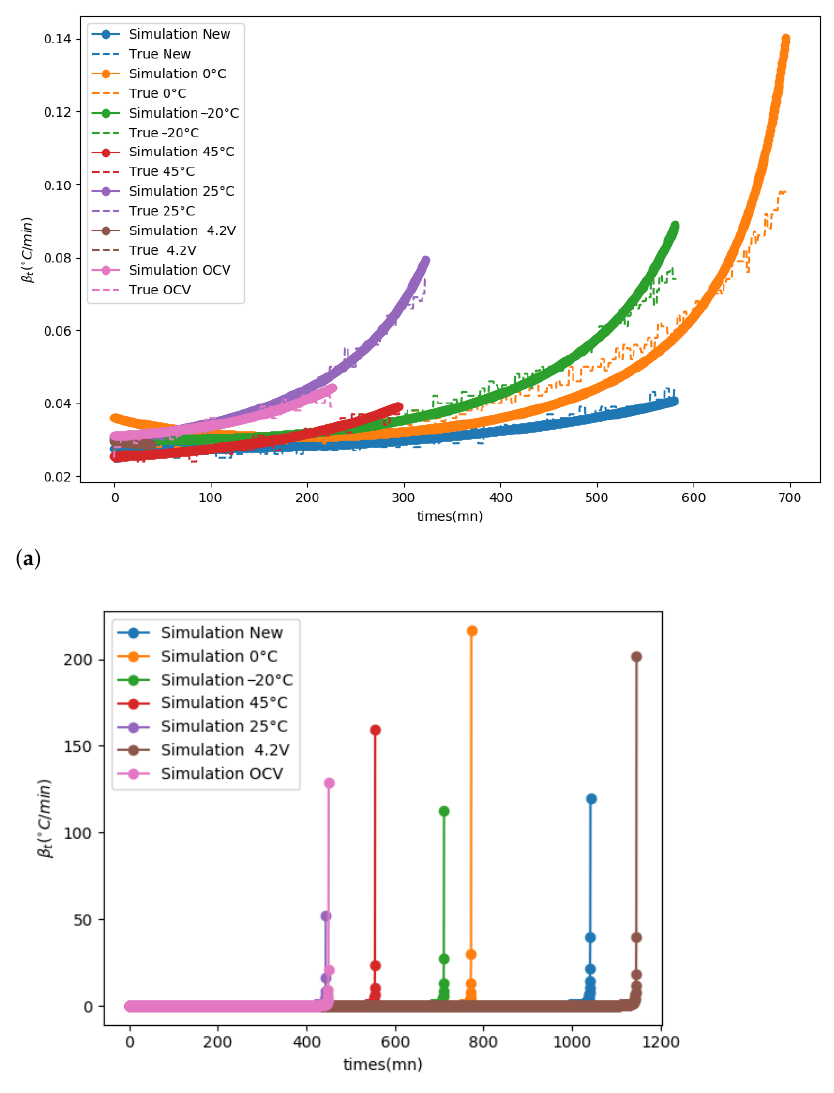
Figure 10. Simulation. ( a ) Simulation of the different kinetics for a time of simulation corresponding to the tests. Comparison with the test data. ( b ) Simulation of the different kinetics considering that no other reaction occurs until the